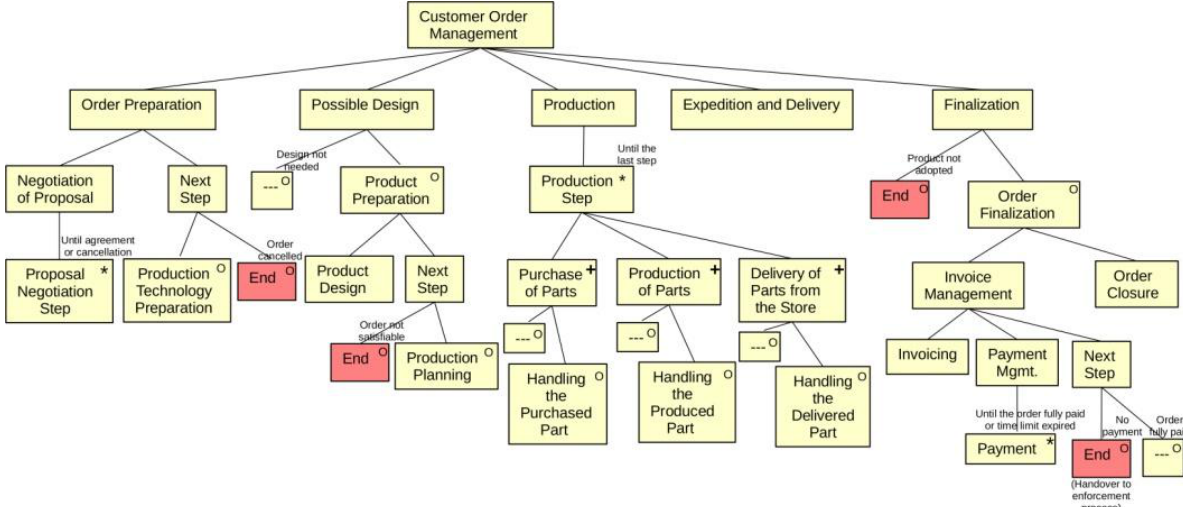
Figure 10. Structural view of the